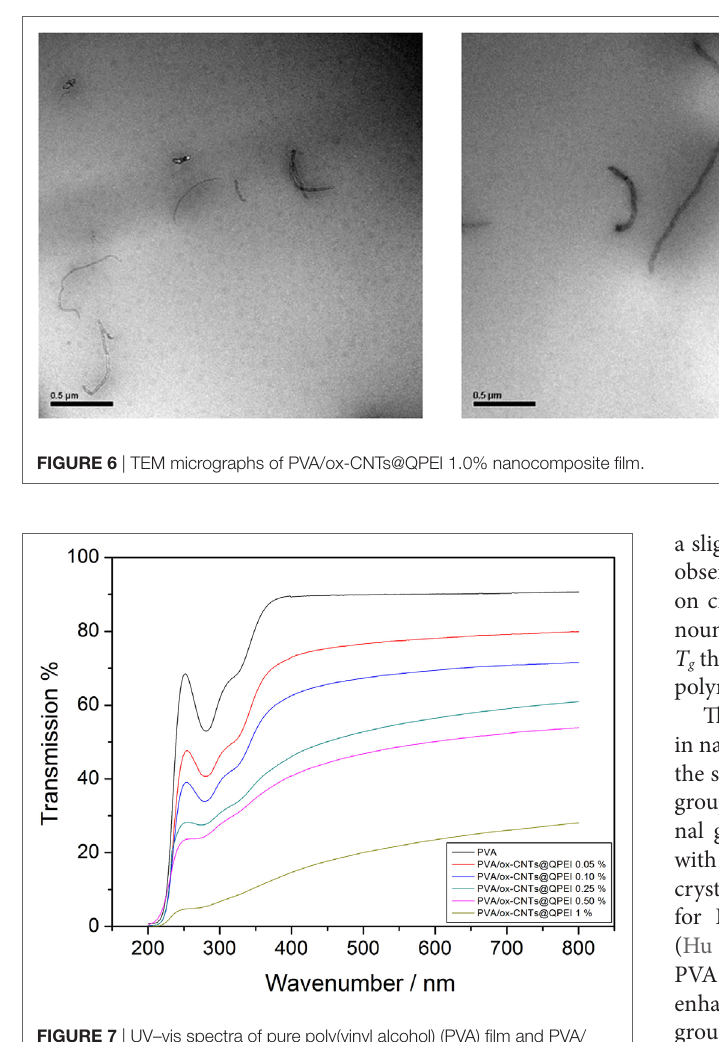
FigUre 7 | UV–vis spectra of pure poly(vinyl alcohol) (PVA) film and PVA/ ox­CNTs@QPEI nanocomposite films.